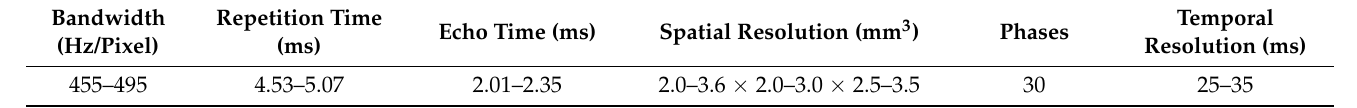
Table 2. Acquisition parameters for 4D flow.